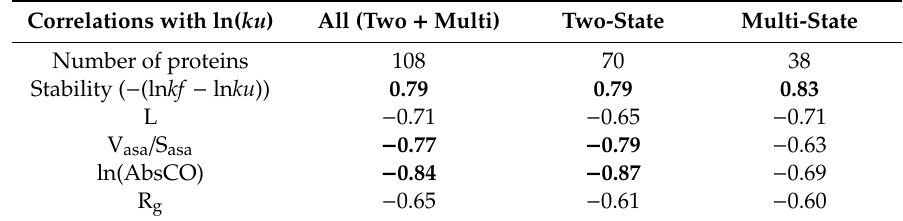
Table 3. Correlations logarithm of the unfolding rate (ln( ku )) with protein stability ( − (ln kf − ln ku )) and structural parameters (L, V asa / S asa , ln(AbsCO) and R g ) for 108 proteins. Correlations with ln( ku ) All (Two + Multi) Two-State Multi-State Number of proteins